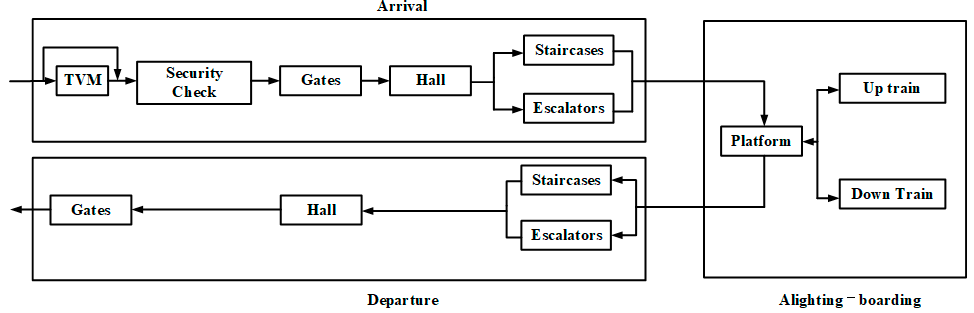
Figure 1. Passenger gathering and scattering process at a subway station.